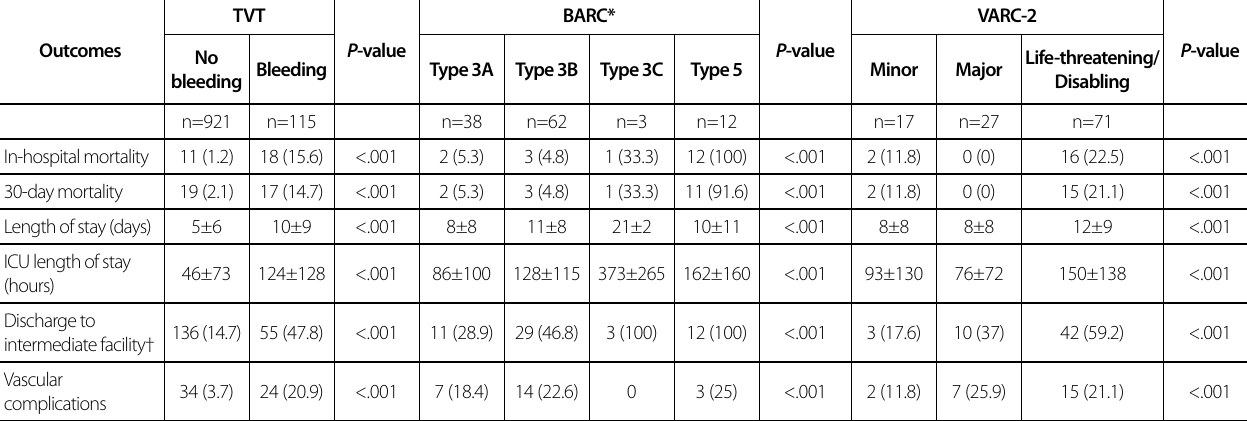
Table 1 . Postprocedural outcomes of patients undergoing TAVR according to their IHB complications per BARC, STS/ACC TVT, and VARC-2